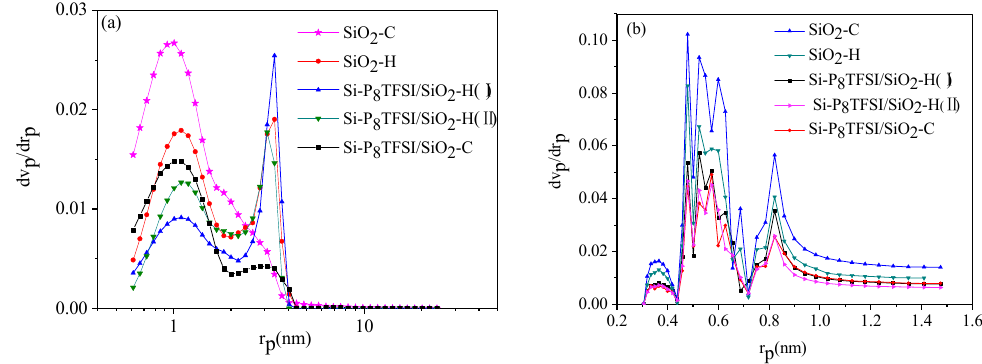
Figure 5. Pore size distribution of silica and modified silica based on: ( a ) N 2 adsorption isotherms at − 196 °C and ( b ) CO 2 adsorption isotherms at 0 °C.